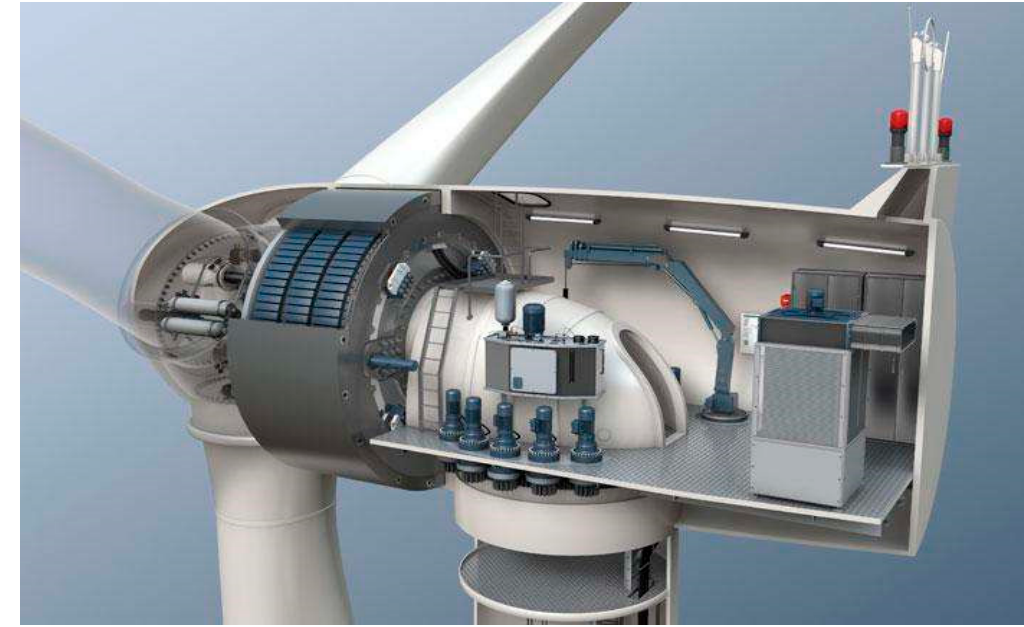
Figure 4. Permanent magnet synchronous generator (PMSG).